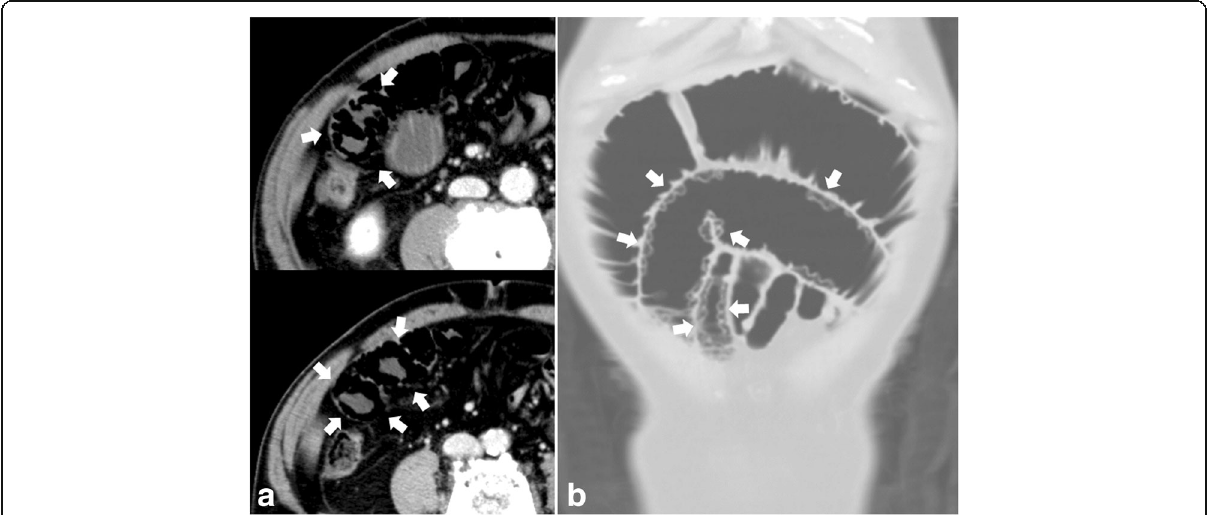
Fig. 1 Computed tomography (CT) scan findings. Abdominal CT scans revealed dilatation of the small bowel from the duodenal third portion to the jejunum. Axial sections revealed dilated loops with a ring-like appearance due to intramural gas ( a ). Coronal section revealed multiple gas-filled cysts along the wall of the dilated jejunum ( b ). Arrows indicate pathognomonic intramural gas